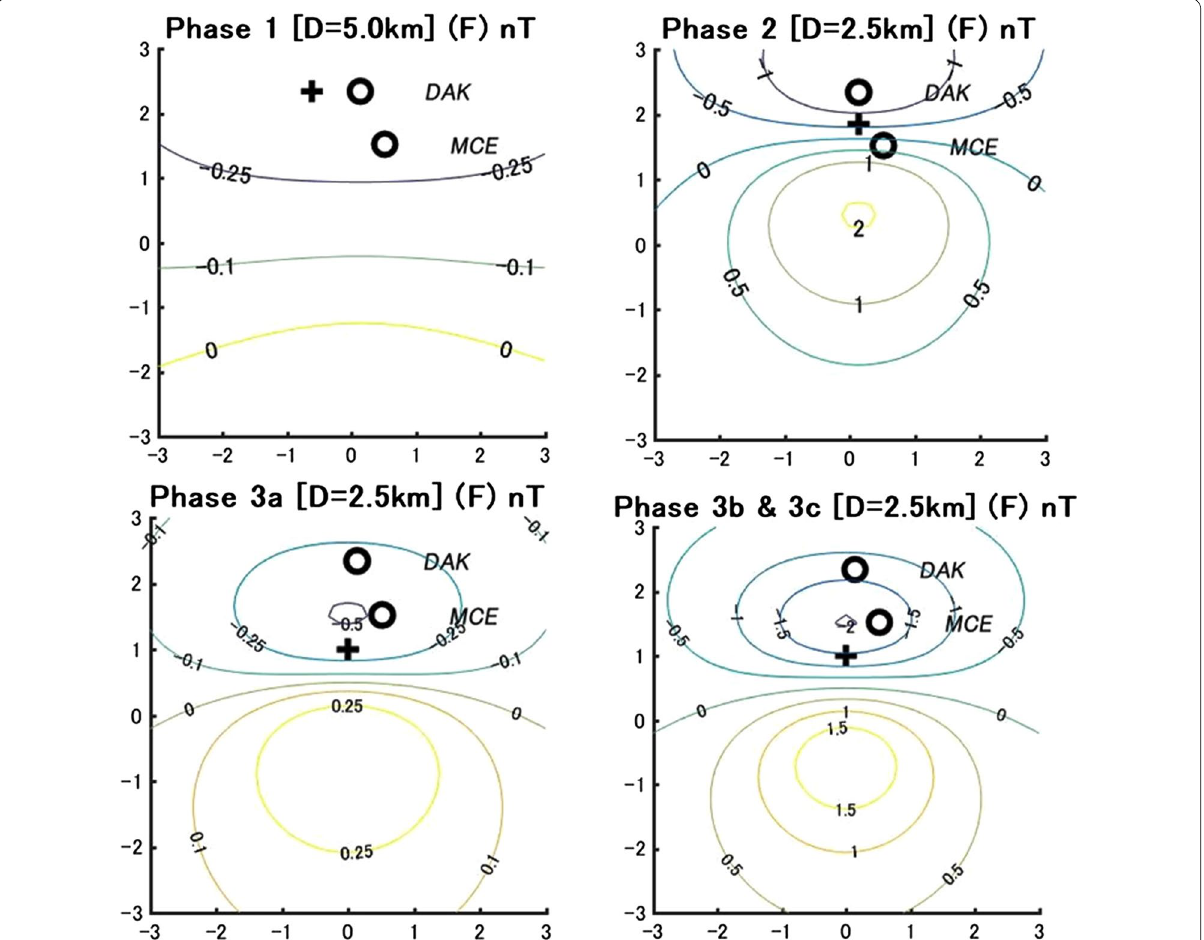
Fig. 10 Upper left: Computed piezomagnetic TMF change associated with the Phase 1 source. See text for source details. Upper right: Computed piezomagnetic TMF change associated with the Phase 2 source inflation. See text for source details. Bottom left: Computed piezomagnetic TMF accompanying an inflation pulse during overall deflation in Phase 3a. Bottom right: Computed piezomagnetic TMF change associated with inflation pulses during overall deflation in Phase 3b and 3c. In these figures, the horizontal position of each pressure source is indicated by black cross